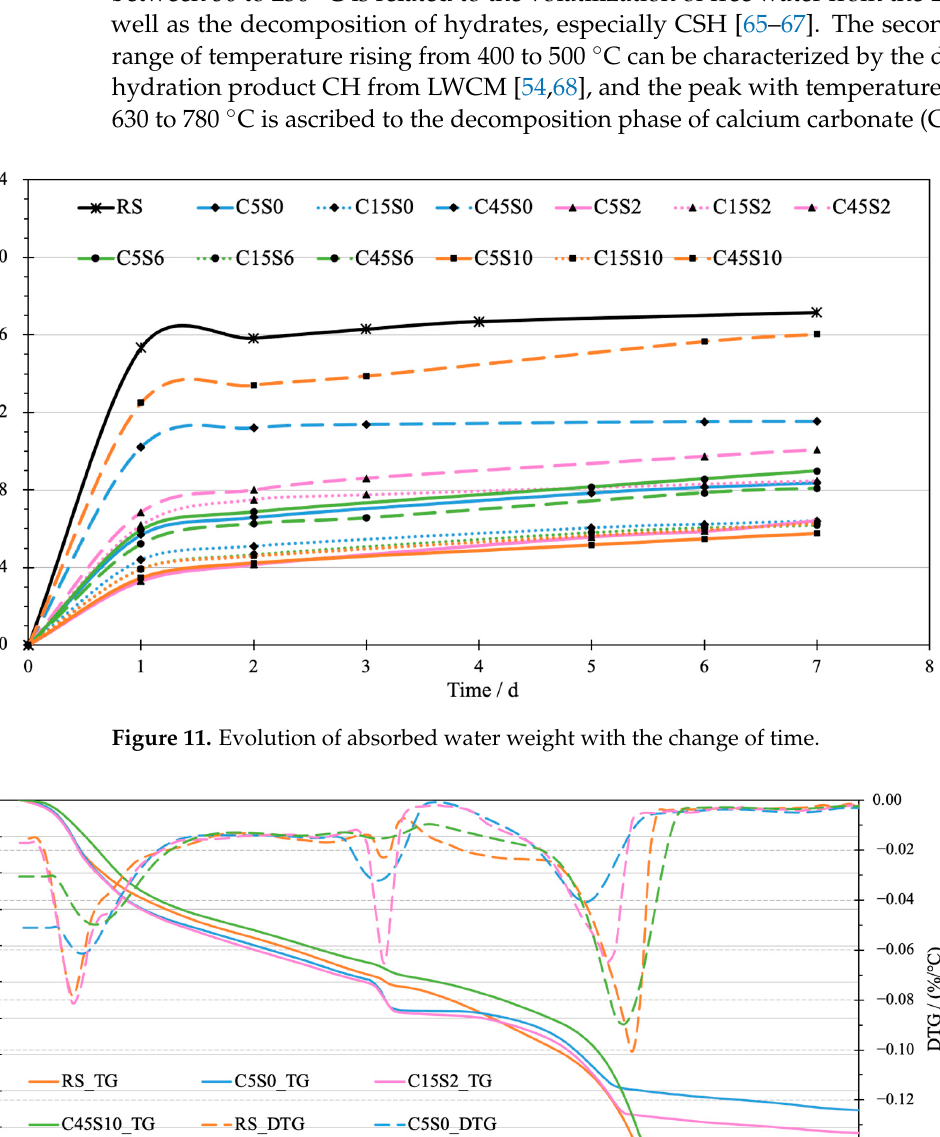
Figure 13. Dehydration and dihydroxylation values in TG analysis. 3.5. Scanning Electron Microscope (SEM) In Figure 14, the Micrographs of specimens RS, C5S0, C45S10, and C15S2 at the mag- ni fi cation of 250, 500, and 1000 were scanned via scanning electron microscope (SEM) to evaluate the dispersion quality of nanomaterials as well as their interaction with the ce- mentitious matrix.